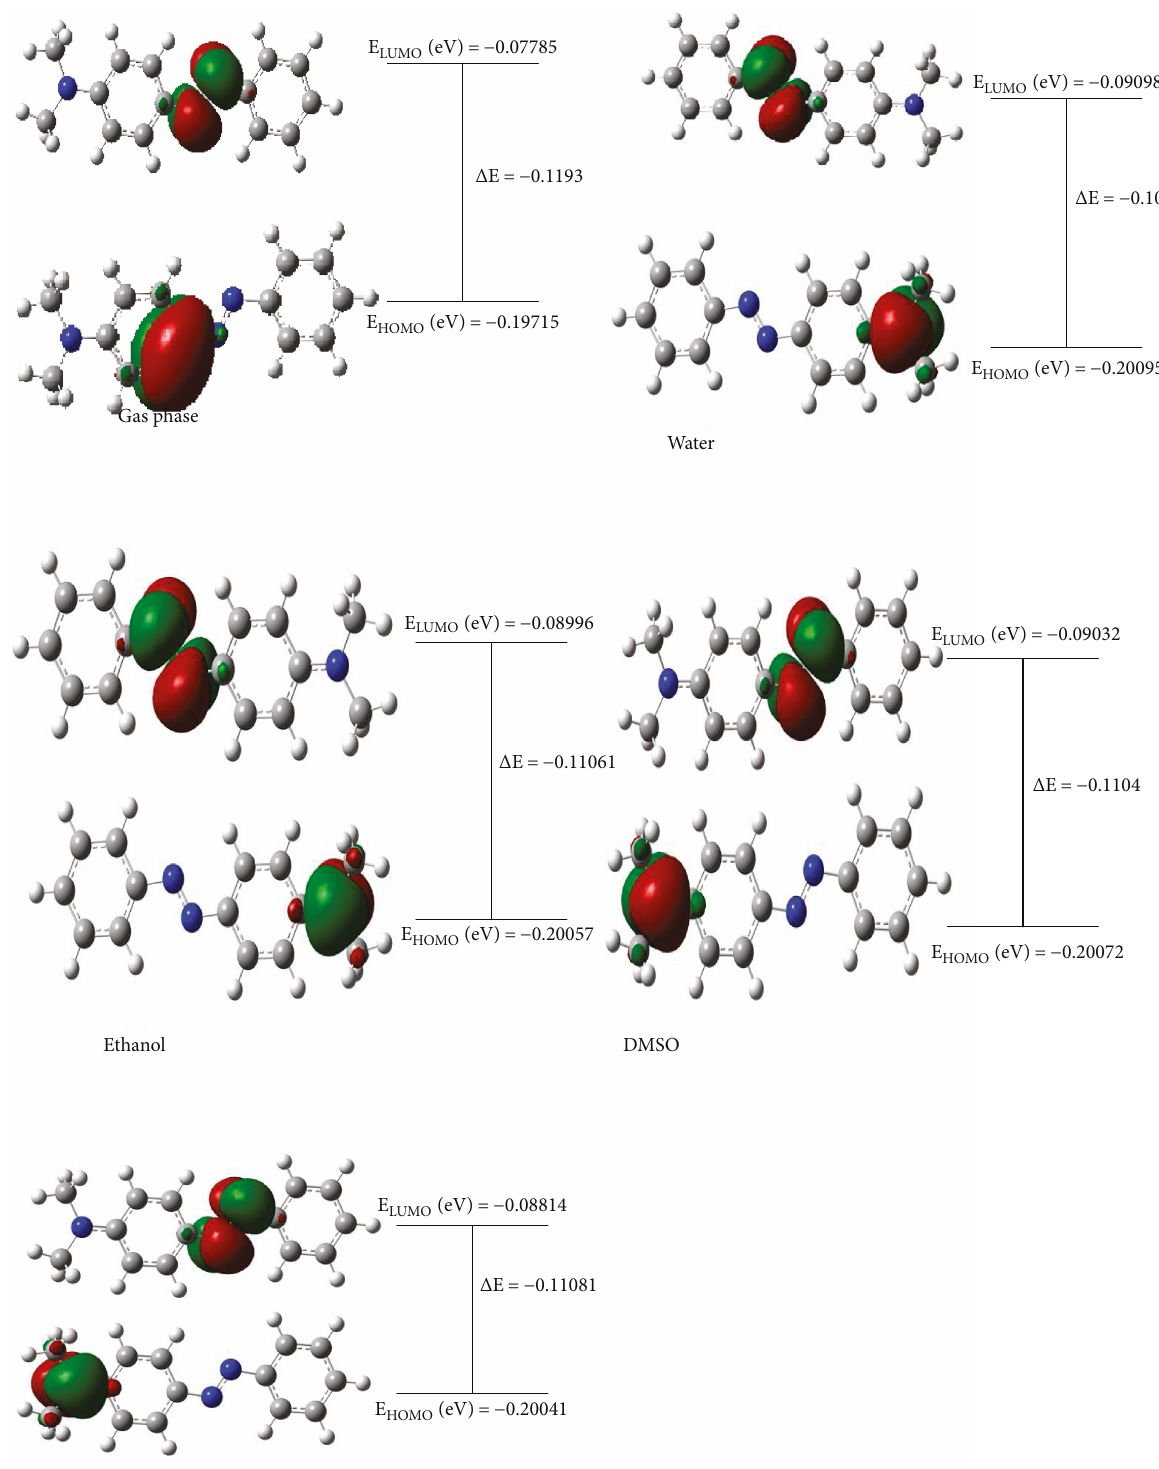
Figure 5: The HOMO-LUMO orbitals and the energy gap of DMAB in gas and di ff erent solvent phases (DMSO, ethanol, acetonitrile, and water) computed at the DFT/B3LYP/6-311G++